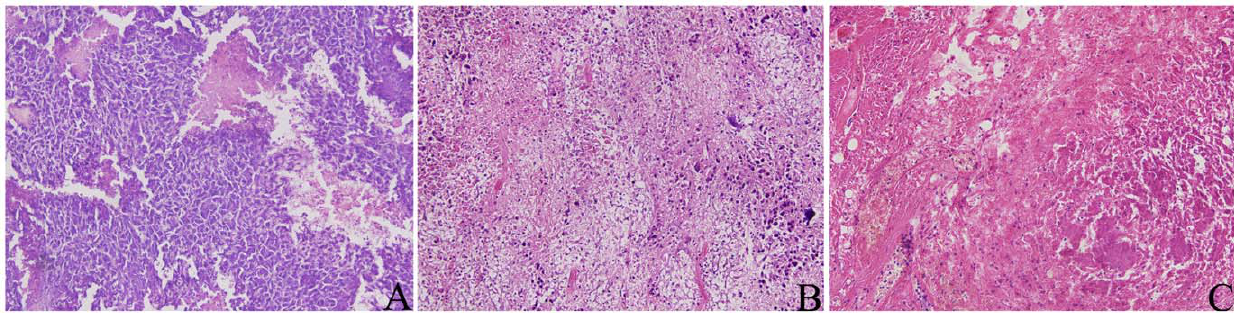
Figure 2. Hematoxylin and eosin staining of the tumor tissues. (A) 1 day prior to the IRE operation, the tumor cells displayed a large nucleus surrounded by a well marked cytoplasm and a well defined cell membrane; (B) 1 day after IRE, obvious tissue necrosis appeared; (C) 3 days after IRE,